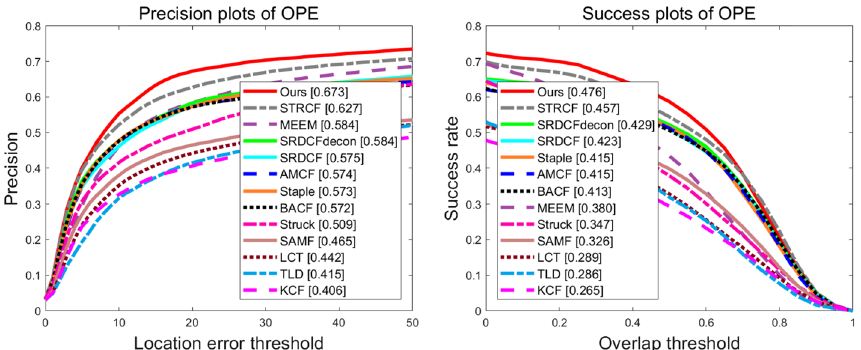
Fig. 5 Precision and success plots of all trackers on 123 UAV